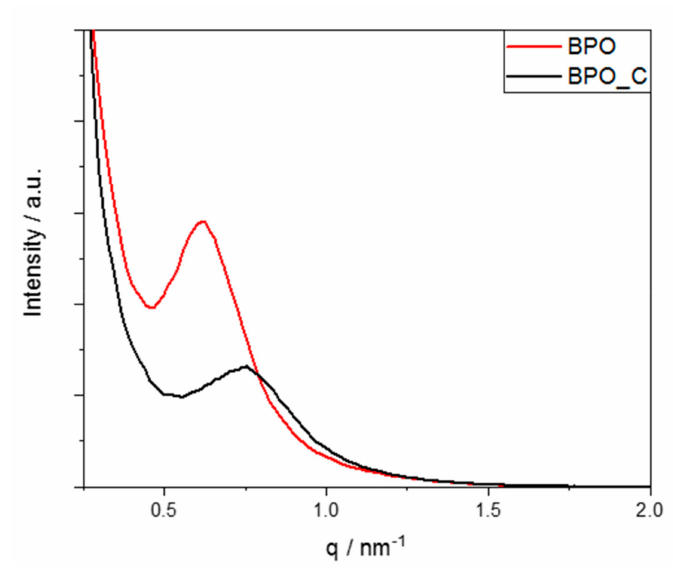
Figure 3. SAXS measurements for samples BPO and BPO-C.